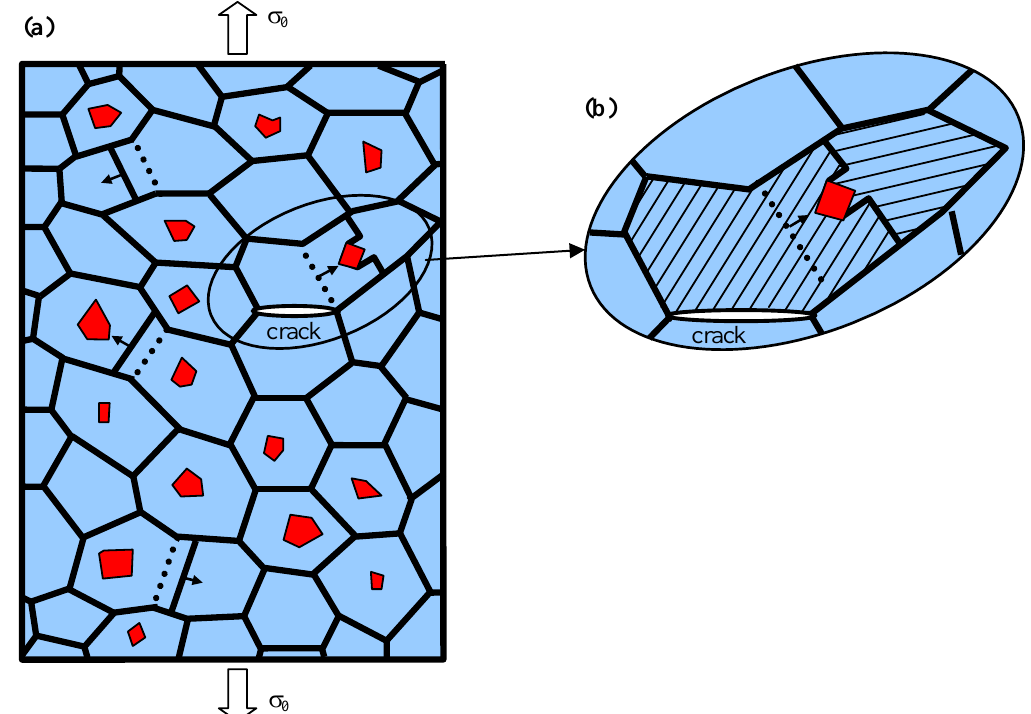
Fig. 1. Stress-driven migration of a grain boundary in a cracked nanocomposite solid containing hard (ceramic or metallic) nanoinclusions inside grains of a metallic matrix. (a) A nanocomposite specimen is under a mechanical load (a two-dimensional general view). (b) The magnified region highlights the state of the nanocomposite, after the stress-driven grain boundary